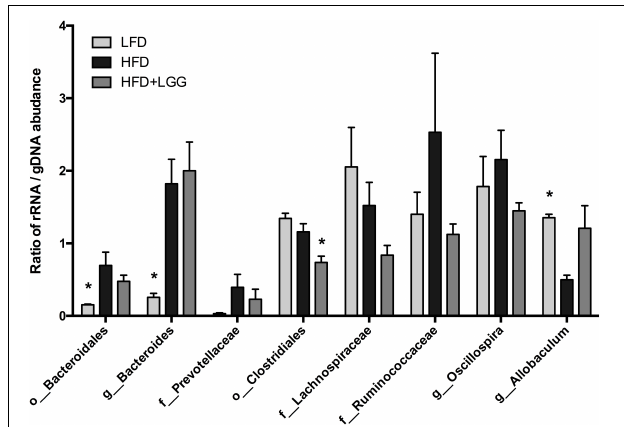
FIGURE 6 | Ratio of rRNA/gDNA abundance in the microbiome of LFD, HFD, and HFD+LGG groups. Significance level was calculated by using ANOVA and Bonferroni’s multiple comparisons test; results are illustrated as ∗ p < 0.05, ∗∗ p < 0.01, ∗∗∗ p <